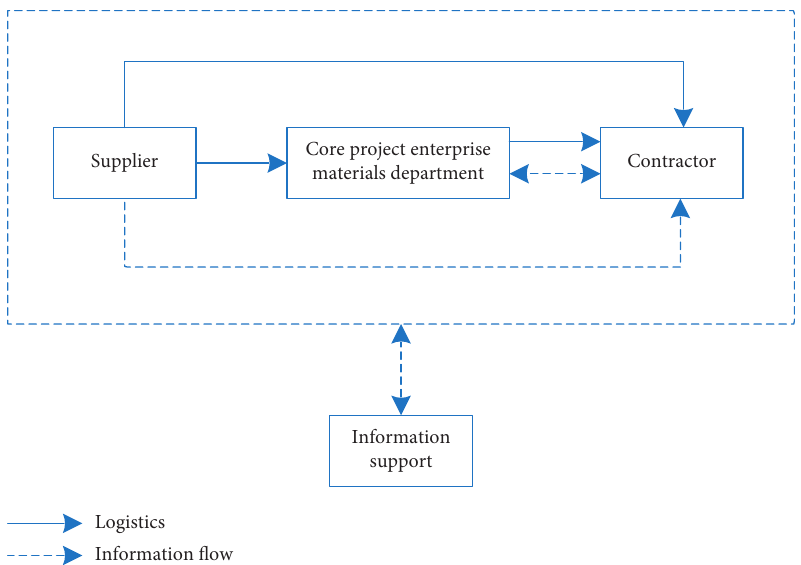
Figure 2: Project organizational logistics scheduling